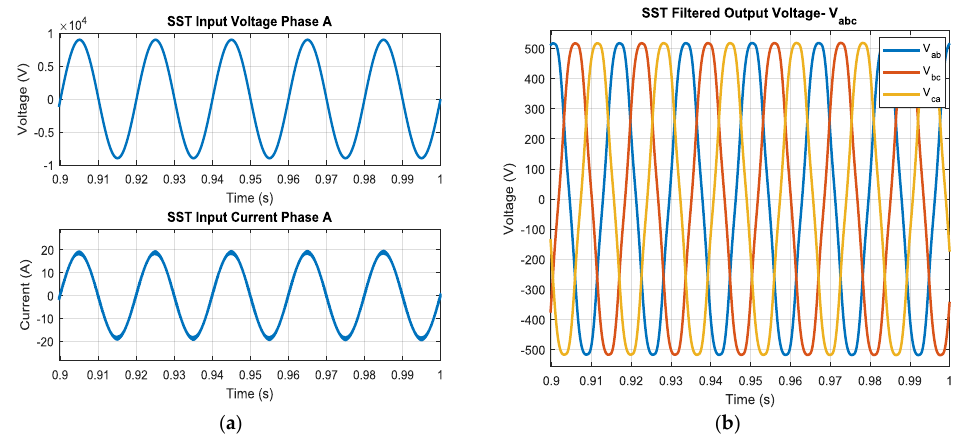
Figure 20. SST 50 Hz filtered output voltage.